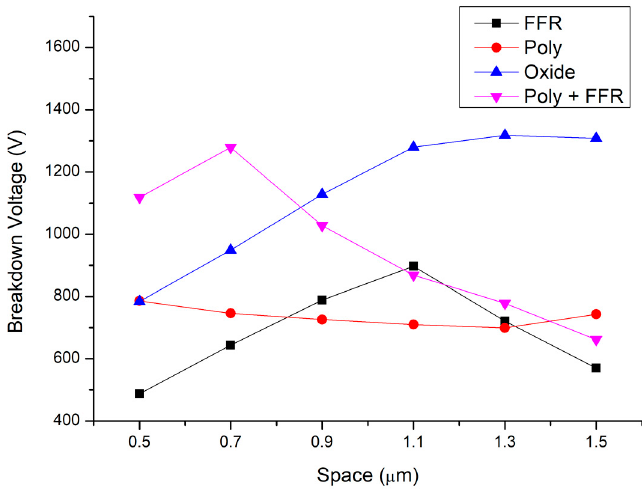
Figure 2. Breakdown voltages of various edge-termination structures versus different spaces.